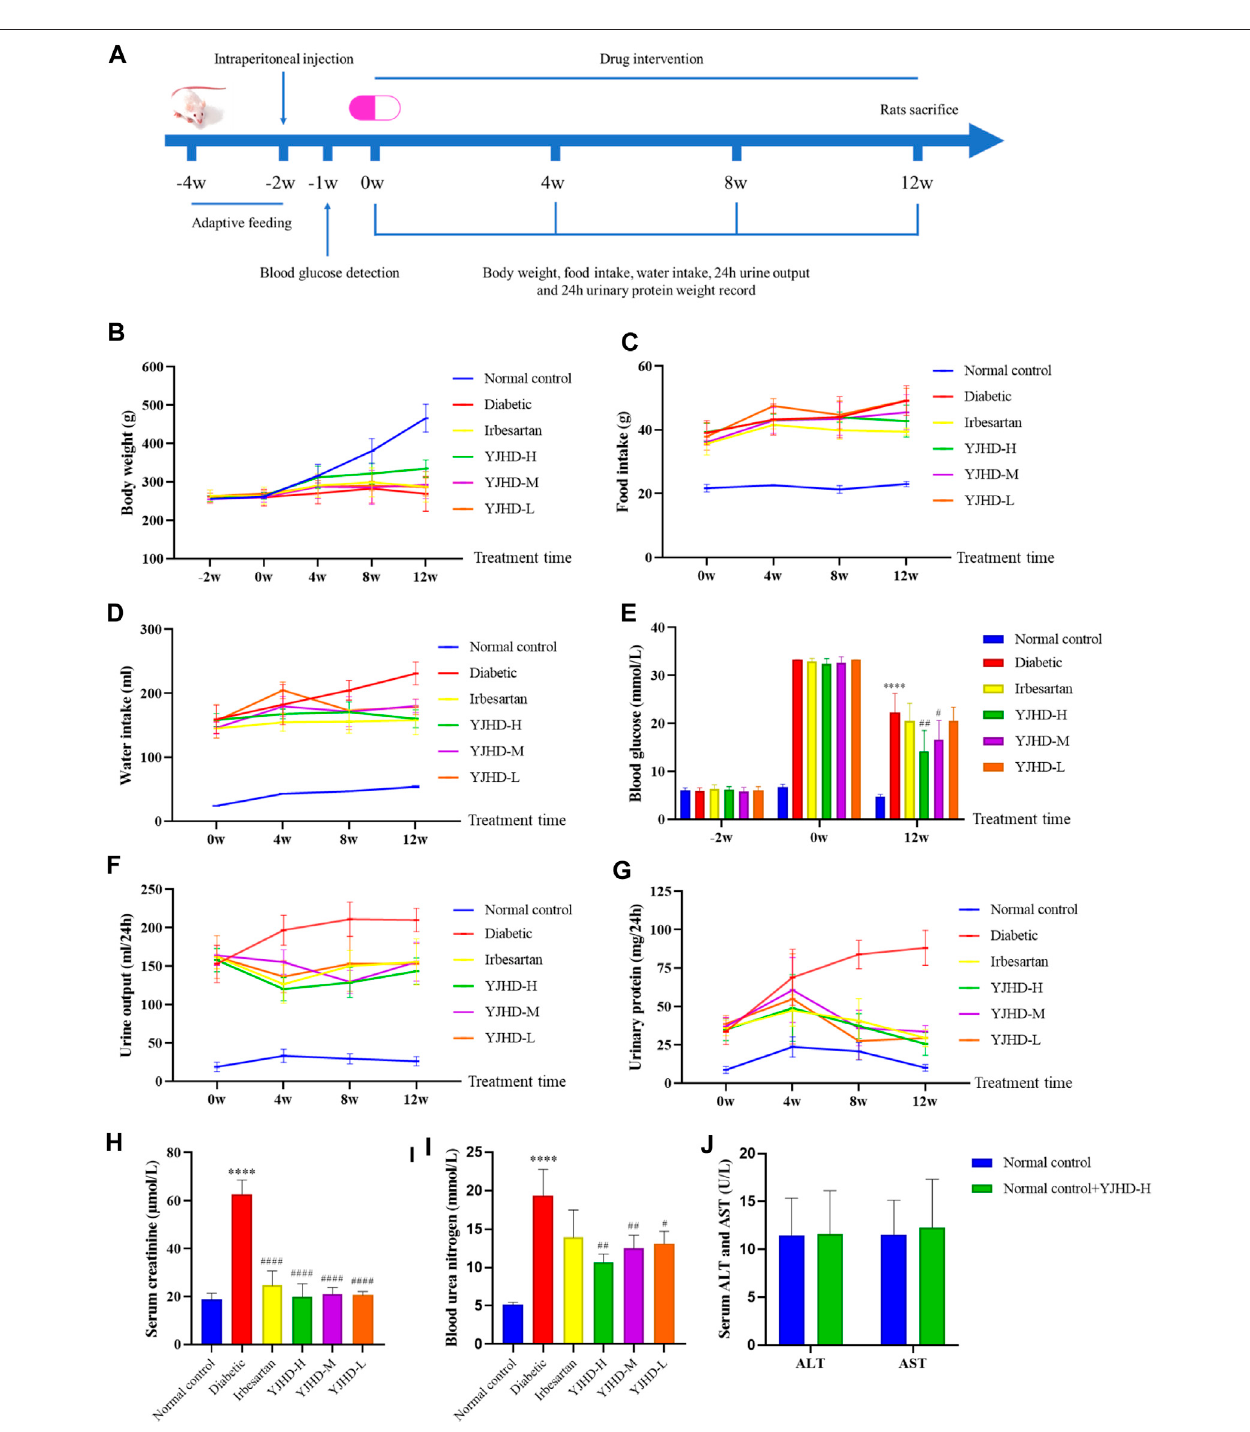
FIGURE2| YiqiJieduHuayudecoction(YJHD)improvesdiabeticsymptomsandrenalfunction. (A) Timelineofanimalexperiments. (B – D) Changesinbodyweight and 24-h food and water intake of rats during drug intervention (recorded every 4 ° weeks). (E) Changes in blood glucose before and after drug intervention. (F, G) Changes in 24-h urine volume and 24-h urinary protein quanti fi cation during drug intervention (measured every 4 ° weeks). (H, I) Serum creatinine (Cr) and blood urea nitrogen(BUN)levelsafterdrugintervention. (J) Serumalanineaminotransferase(ALT)andaspartateaminotransferase(AST)levelsafterdrugintervention.Thedata areexpressed as**** p < 0.0001:compared withthenormalcontrolgroup; # p < 0.05,## p < 0.01,and #### p < 0.0001:comparedwiththediabeticgroup, respectively.